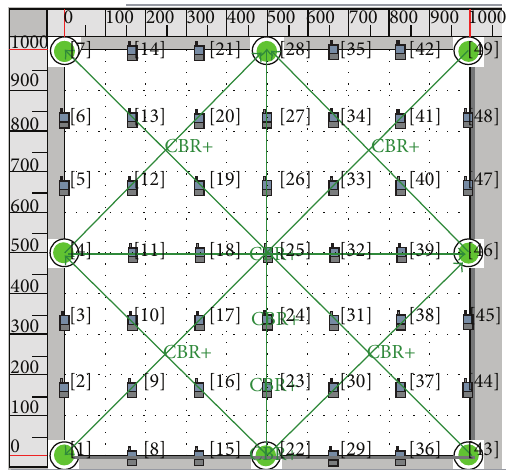
Figure 5: The simulation topology with 49 nodes and 16 CBR connections.